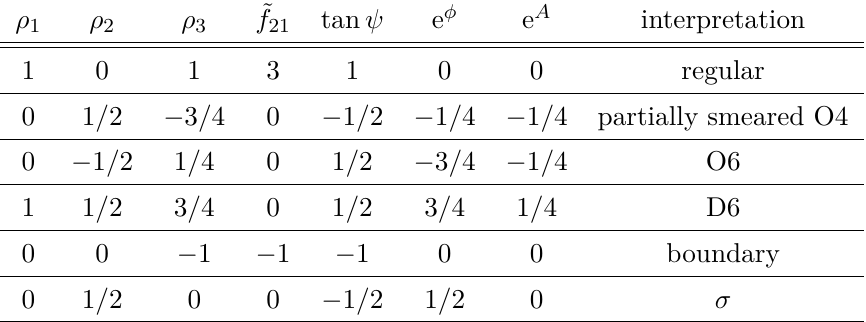
Table 1. Some notable boundary conditions. The numbers denote the leading powers of the corresponding variables. The regular, D6-brane and O6-plane require fine-tuning, while the others occur as